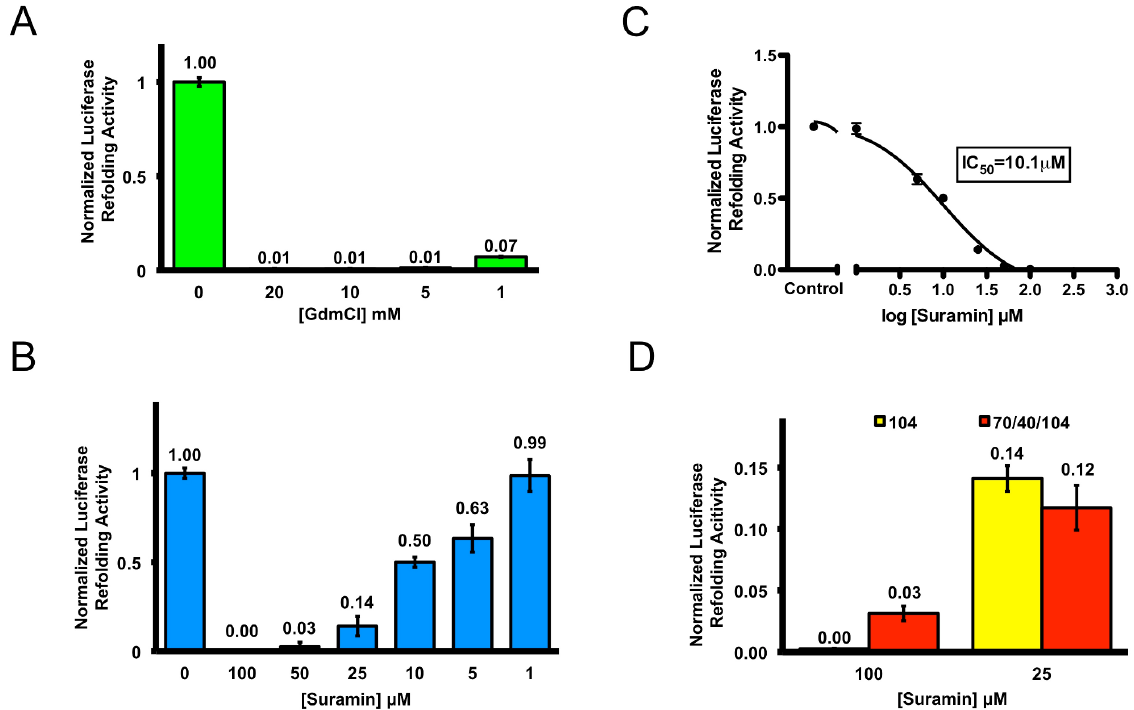
Figure 3. Suramin greatly inhibits Hsp104 refolding activity. ( A ) Urea-denatured firefly luciferase aggregates were incubated for 90 min at 25 u C with Hsp104 (1 m M hexamer) plus 1:1 mixtures of ATP and ATP c S and varying concentrations of GdmCl. Luciferase reactivation was then determined and converted to % WT disaggregase activity in the presence of ATP c S: ATP. Values represent mean 6 S.D. ( n =3–6). ( B ) Reactions were performed as in ( A ) except varying concentrations of Suramin were used. Values represent mean 6 S.D. ( n =6–10). ( C ) Half maximal inhibitory concentration (IC 50 ) for Suramin-mediated inhibition of Hsp104. IC 50 was calculating by fitting luciferase-refolding data at different Suramin concentrations. ( D ) Reactions were performed as in ( A ) except that 1:1 mixtures of ATP and ATP c S were replaced with Hsp70 (1 m M) and Hsp40 (1 m M) plus ATP. The Hsp104 alone condition (yellow bars) was carried out with 1:1 mixtures of ATP and ATP c S as in ( A ). Each condition is normalized to the refolding activity in each corresponding condition in the absence of